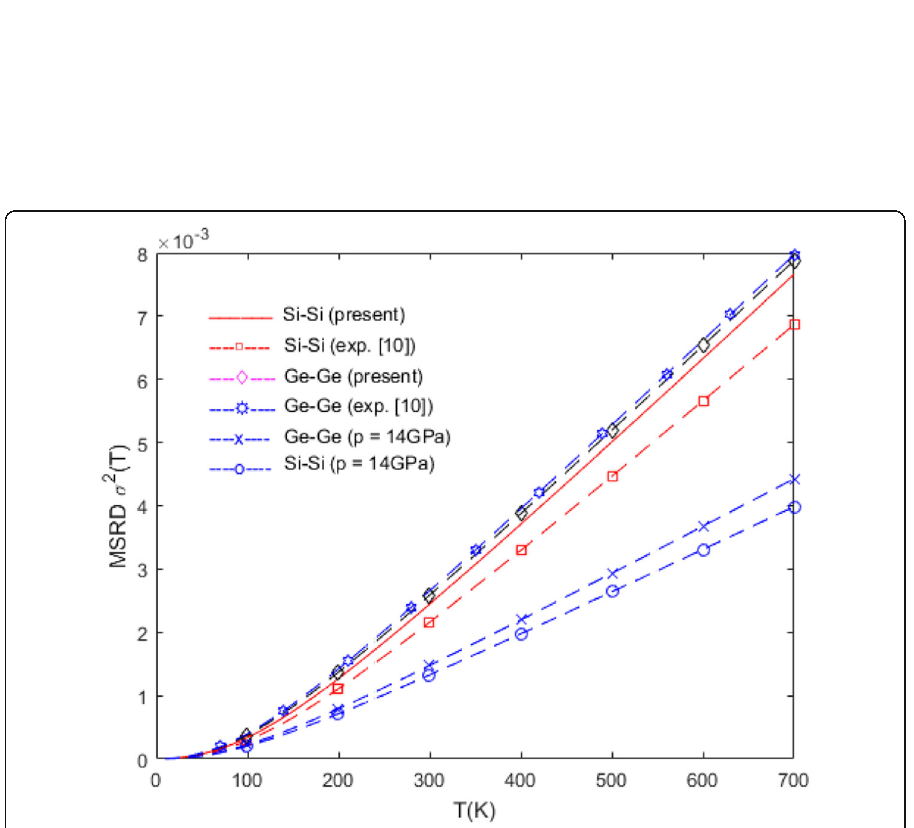
Fig. 7 Dependence on temperature of mean square relative displacement MSRD under pressure effects